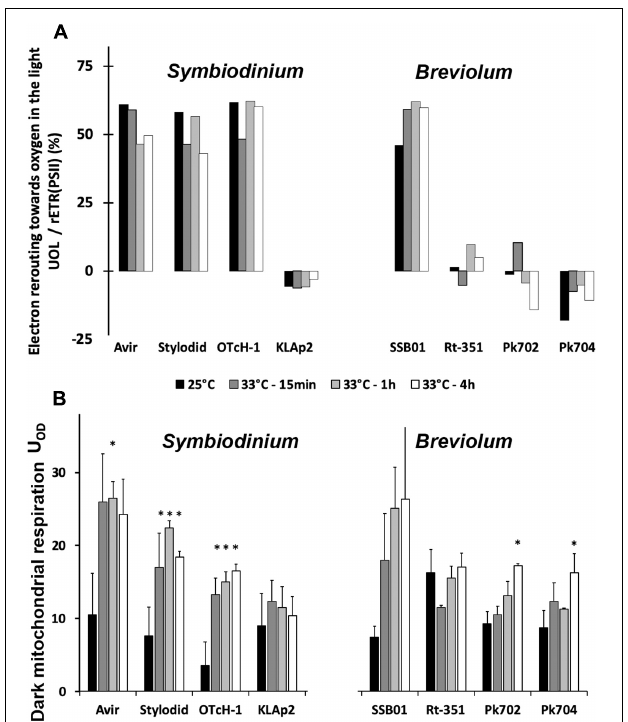
FIGURE 4 | Oxygen exchanges during heat stress in Symbiodinium and Breviolum strains. (A) Fraction of relative electron transport rate of photosystem II (rETR PSII ) that is diverted to oxygen reduction (U OL ) in saturating light intensity (900 µ mol photons m − 2 s − 1 ). Values were calculated from the averaged plots in Figure 3 . ∗ value differs significantly ( P < 0.05) from the control value at 25 ◦ C. (B) Oxygen uptake in the dark (U OD , pmol O 2 µ g chl − 1 s − 1 ) retrieved out of Supplementary Figure 3 . All measurements were performed on three biological replicates and data are presented as means ± SD.